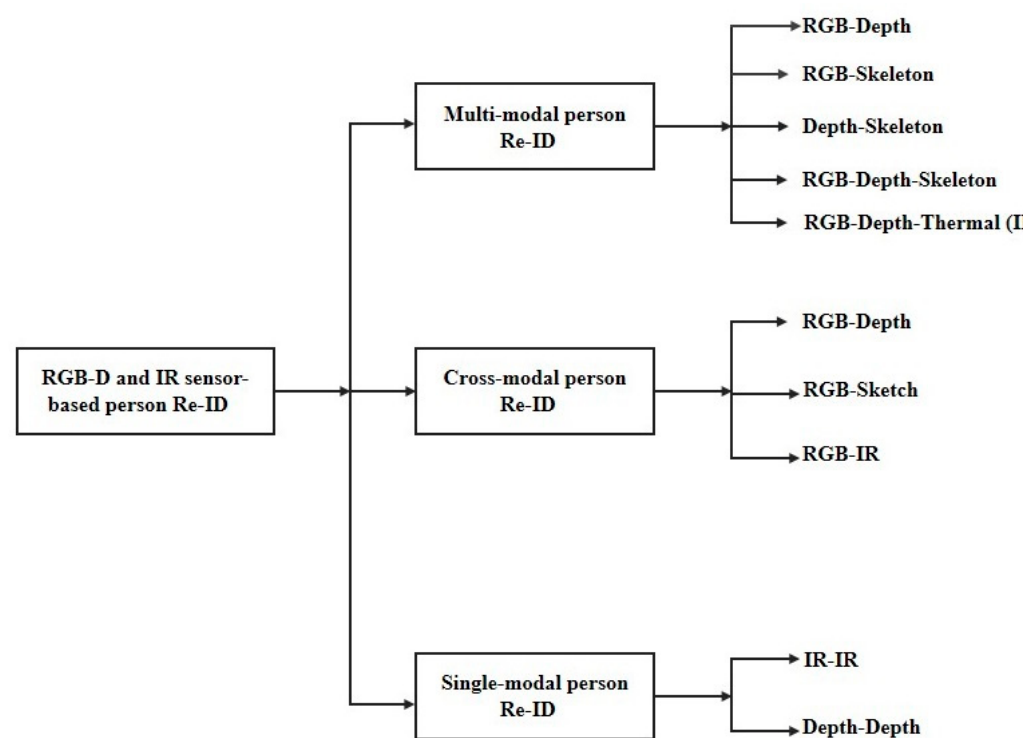
Figure 3. General categories of RGB–D and IR sensor-based person re-identification systems.